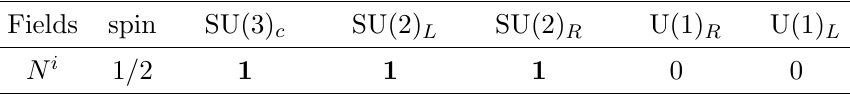
Table 4 . Neutrinos in the model. i denotes the (cid:13)avors: i = 1 ; 2 ;